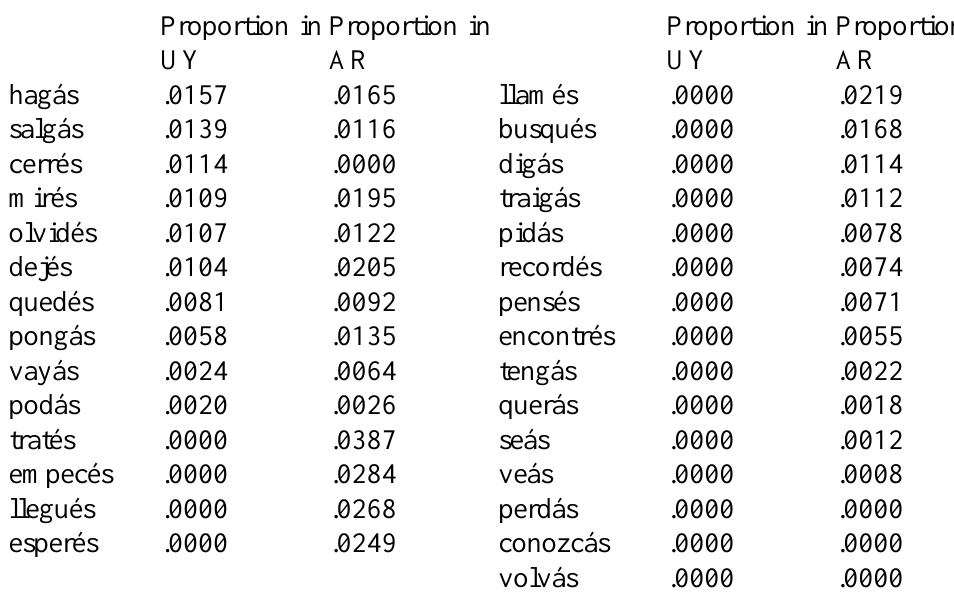
Table 3. Non-standard present subjunctive forms with final stress. Data from Corpus del español /Web